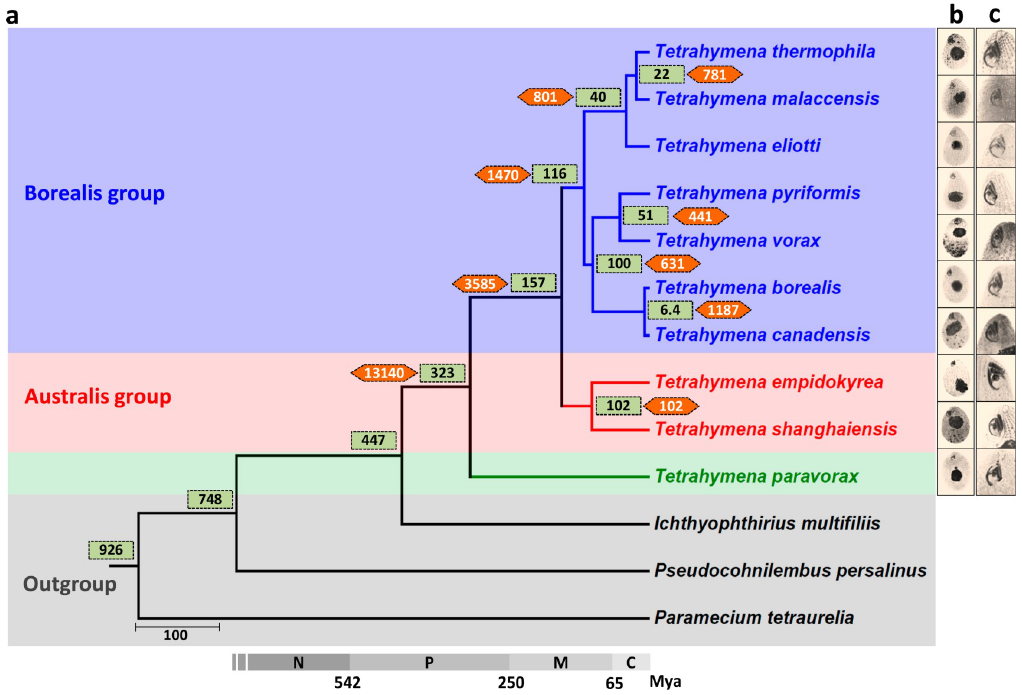
Fig 1. Phylogenetic tree and estimated divergence times of 10 morphologically similar Tetrahymena species. (a) Maximum likelihood species tree, using 198 one-to-one orthologs, 104,434 amino acid sites, and 1,000 bootstraps. Green boxes, estimated divergence times for each node; orange hexagons, number of shared ortholog groups for each node; gray bar, geologic timescale. (b) Overall cell morphology and (c) oral apparatus, as revealed by silver-staining. C, Cenozoic; M, Mesozoic; Mya, million years ago; N, Neoproterozoic; P, Paleozoic.